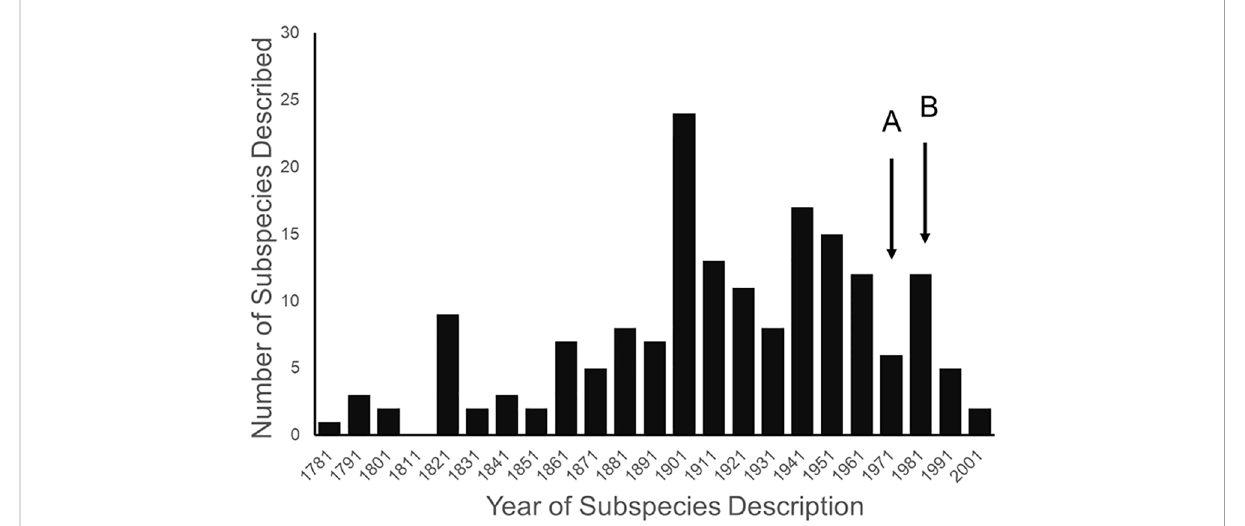
FIGURE 1 Distribution of years in which subspecies listed under the endangered species act were described. Arrow (A) marks the beginning of the use of allozymes in studying genetic variation in natural populations, and arrow (B) marks the beginning of the use of mitochondrial